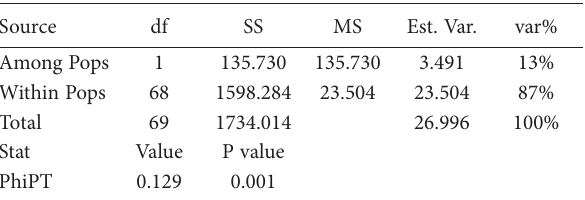
Table S2. AMOVA test based on date palm trees in two groups: male and female trees. df; degree of freedom, SS: sum of square, MA: mean of square, Var: variance.